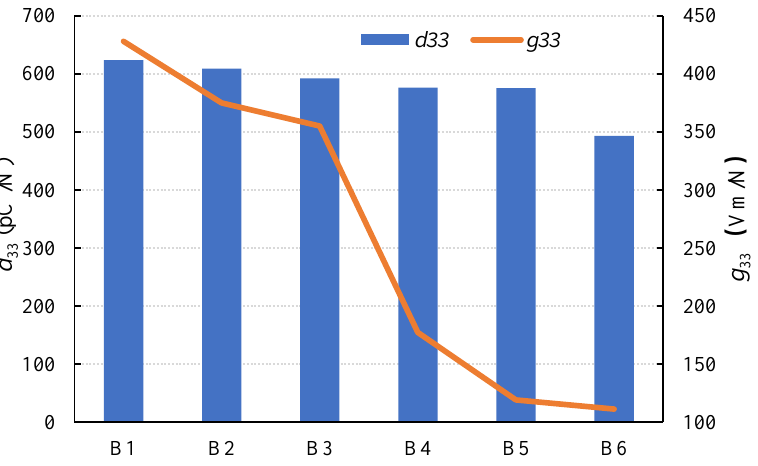
Figure 10. Changes in piezoelectric properties with modulus.